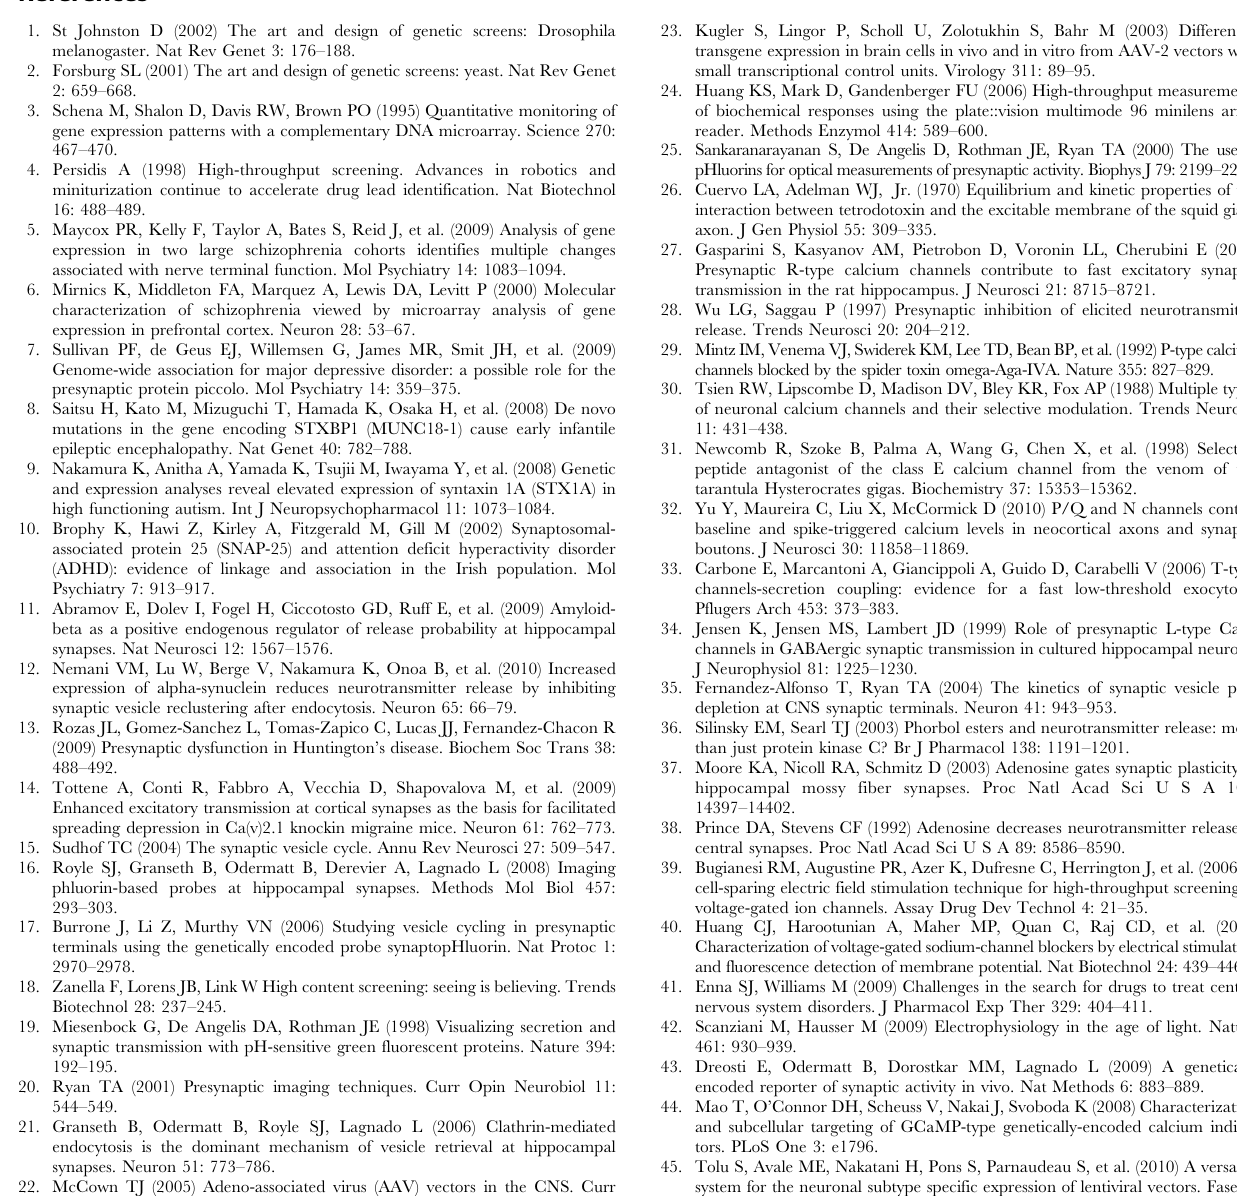
Table S1 Summary statistics from 8 control plates for 5 Hz, 30 sec trains. See Table 1 for explanation. Baseline noise is as in Table 1. (DOC) Table S2 Summary statistics from 8 control plates for 50 Hz, 15 sec trains. See Table 1 for explanation. Baseline noise is as in Table 1. (DOC) Dataset S1 MANTRA system screening data for a single LOPAC plate. (XLS) Dataset S2 MANTRA system screening data for adenosine receptor compound plate.